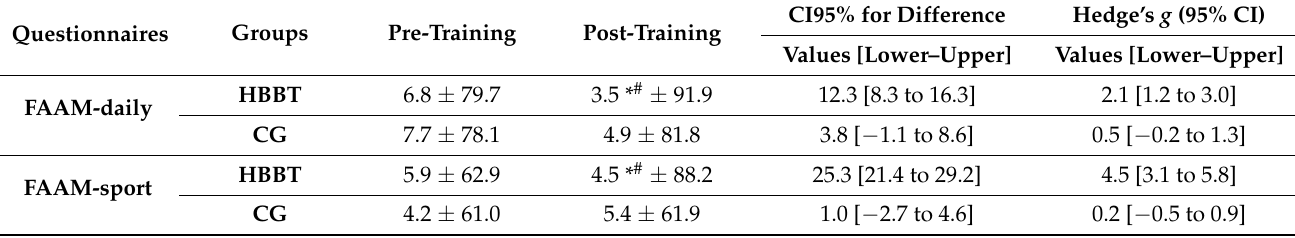
Table 4. Between- and within-group differences in FAAM scores before and after